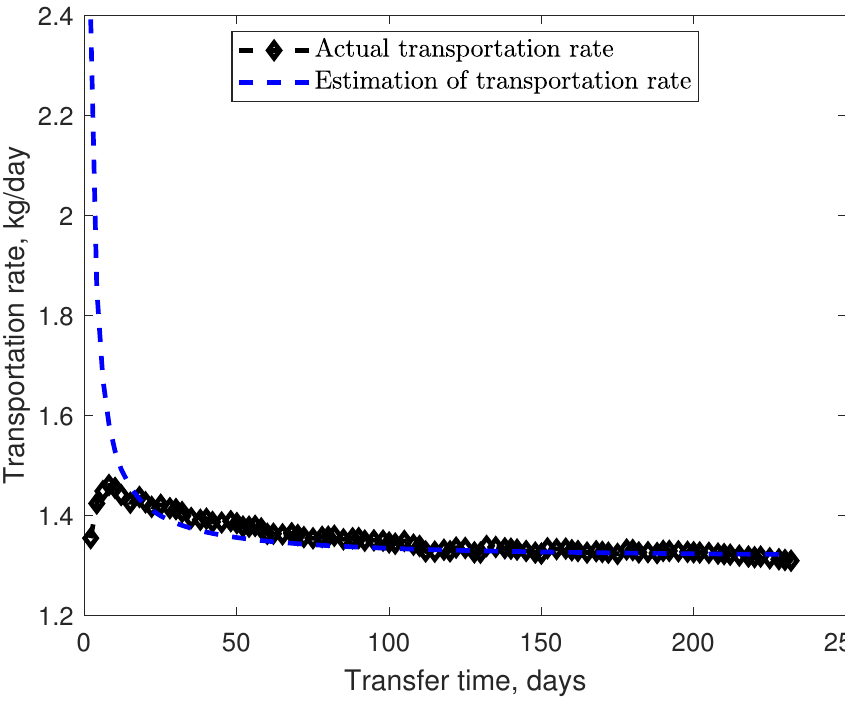
Figure 14. Transportation rate versus transfer time when T max = 100 mN and I sp = 3500